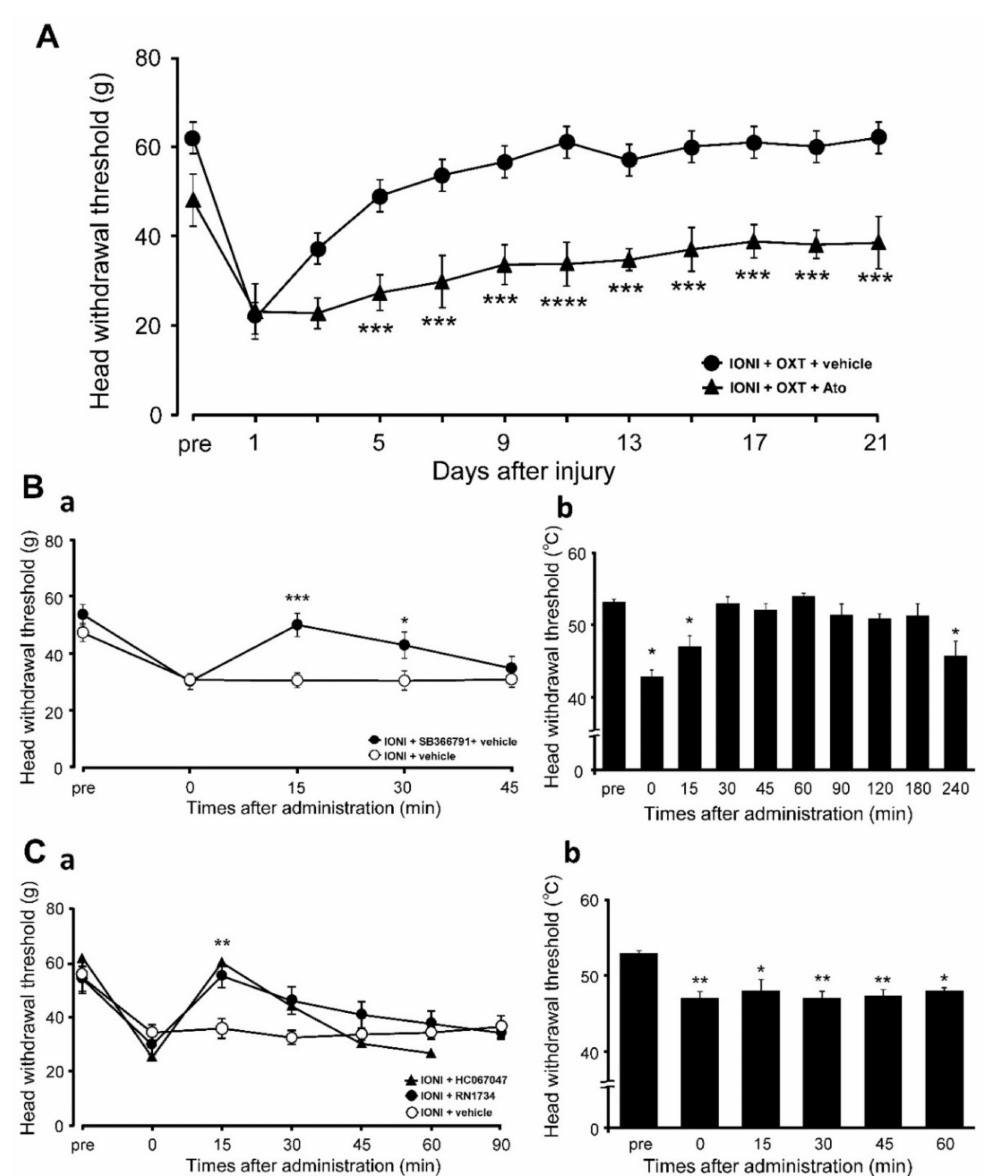
Figure 5. Changes in IONI-induced mechanical hypersensitivities of the whisker pad skin by TRP antagonism. ( A ) The MHWT of the whisker pad skin after IONI with OXT (1.0 × 10 − 6 mol) + vehicle or OXT (1.0 × 10 − 6 mol) + atosiban administration ( n = 10, in each group). *** p < 0.001, **** p < 0.0001 (vs. IONI with the OXT + vehicle group). ( Ba ) The MHWT of the whisker pad skin on day 5 after IONI treatment after vehicle or SB366791 administration ( n = 11, in each group). * p < 0.05, *** p < 0.001 (vs. the vehicle group). ( Bb ) The HHWT of the whisker pad skin after SB366791 administration on day 5 after IONI treatment ( n = 5, in each group). * p < 0.05 (vs. pre value). ( Ca ) The MHWT of the whisker pad skin after IONI with vehicle, RN1734, or HC067047 administration on day 5 after IONI treatment (IONI + RN1734, n = 10; IONI + HC067047, n = 6; IONI + vehicle, n = 9). ** p < 0.01 (vs. IONI + vehicle). ( Cb ) The HHWT of the whisker pad skin after RN1734 administration on day 5 after IONI treatment ( n = 5, in each